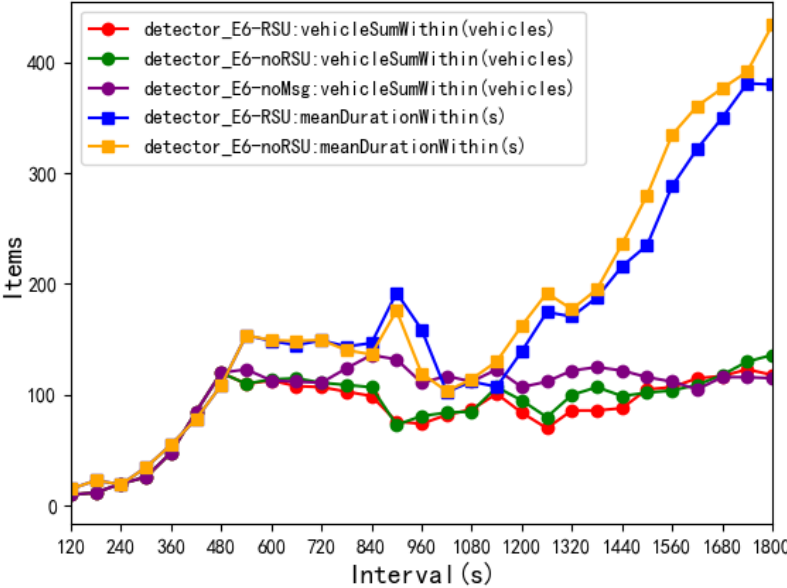
Figure 23. Comparison between connected RSUS and disconnected RSUs scenarios in terms of vehicleSumWithin and meanDurationWithin collected by E3 on intersection E6.